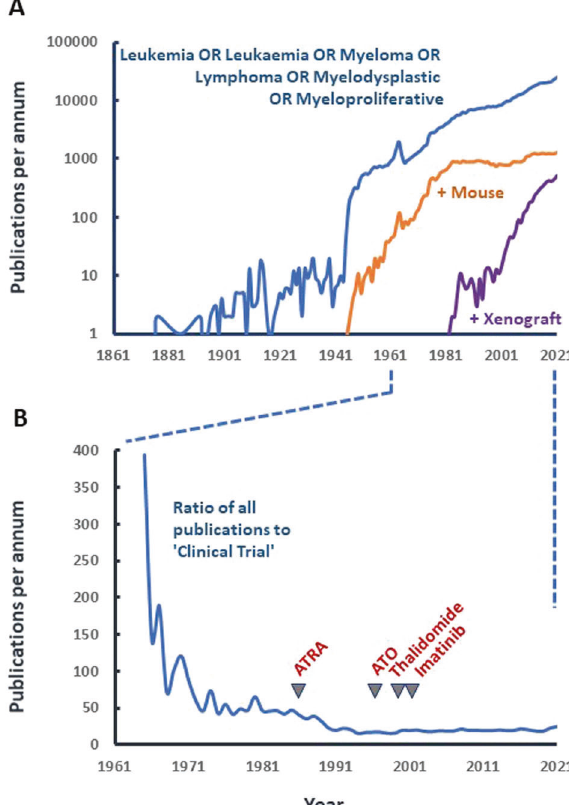
Fig. 1 Numbers of Blood Cancer research articles and the proportion that include clinical trials. Data are from PubMed (03/ 05/2022). A Searches were for articles including the terms; (Leukemia OR Leukaemia OR Myeloma OR Lymphoma OR Myelo- dysplastic OR myeloproliferative) in either the title and/or legend (blue line), the same search with the inclusion of either (i) the term (mouse OR murine) either the title and/or legend (orange line) or (ii) the term (xenograft) either the title and/or legend (purple line). Publications are shown B Data from 1965 – 2021 showing the ratio of total publications retrieved using (Leukemia OR Leukaemia OR Myeloma OR Lymphoma OR Myelodysplastic OR myeloproliferative) in either the title and/or legend with the number retrieved using the same search phrase fi ltered by PuBMed ‘ Clinical Trial ’ function. Arrows indicate the timing of PoC studies for ATRA and ATO in APL, thalidomide in Myeloma and Imatinib in CML as discussed in the main text. The search strategies employed represent underestimates of total research activity as any studies currently in progress, abandoned unpublished are not